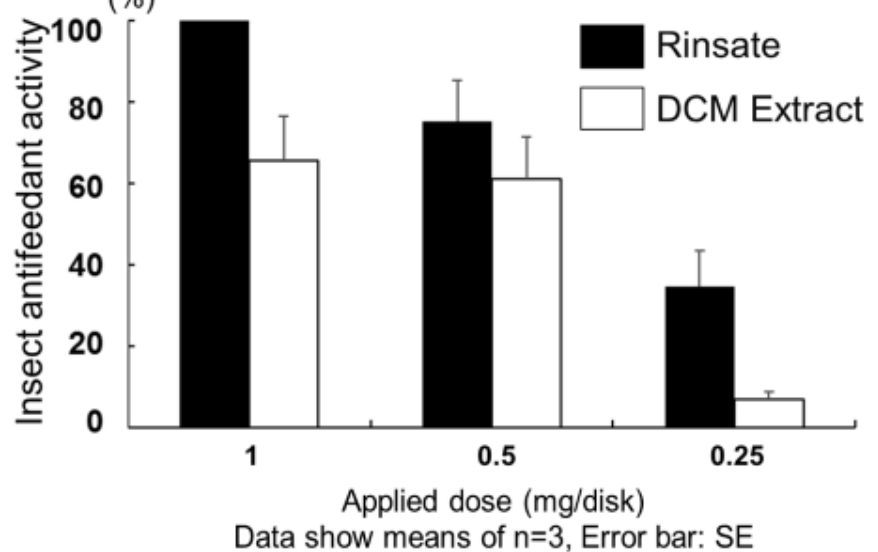
Figure 3. Insect antifeedant activity of rinsate and dichloromethane (DCM) extract from aerial parts of yacón.